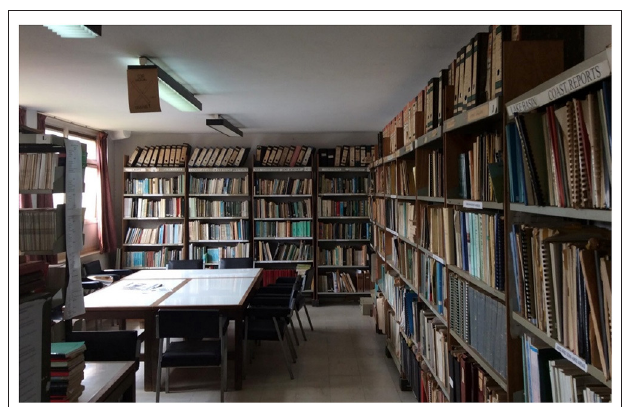
FIGURE 3 | The Kenya Soil Survey library, June 6, 2017. Photo by Joshua O.